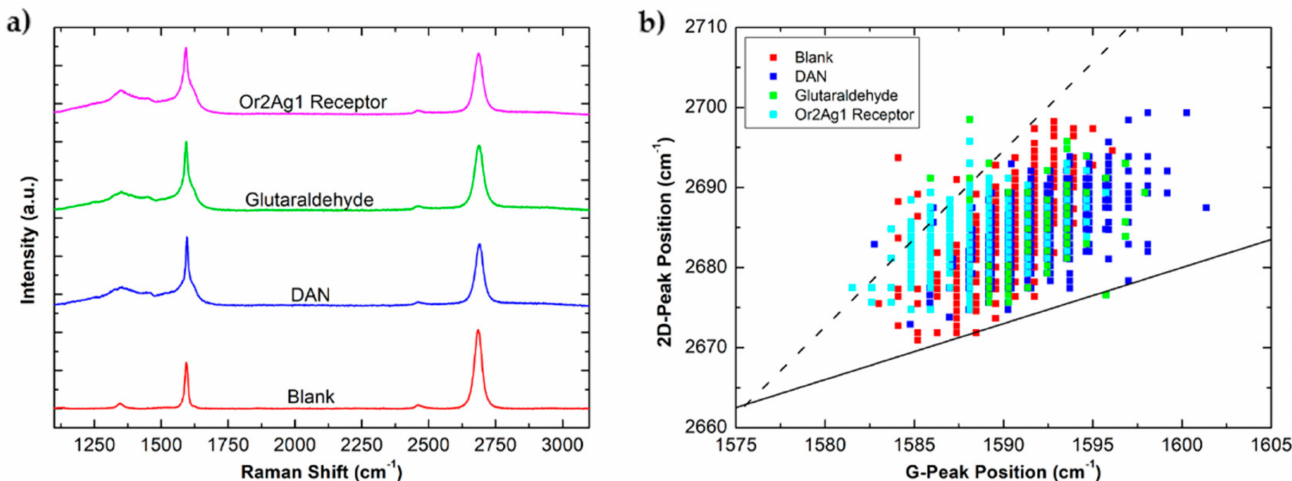
Figure 5. ( a ) Raman spectroscopy of unmodified graphene (red) and graphene after each functionalization step (drop-casting of DAN (blue), followed by glutaraldehyde attachment (green) and lastly OR2AG1 protein receptor (pink). ( b ) Scatter plot showing the shifting in the G-peak and 2D-peak positions, at each functionalization stage, unmodified graphene (red), drop-cast DAN (dark blue), glutaraldehyde attachment (green) and OR2AG1 protein receptor (light blue), indicative of changes in doping and applied strain of the graphene structure, after each functionalization